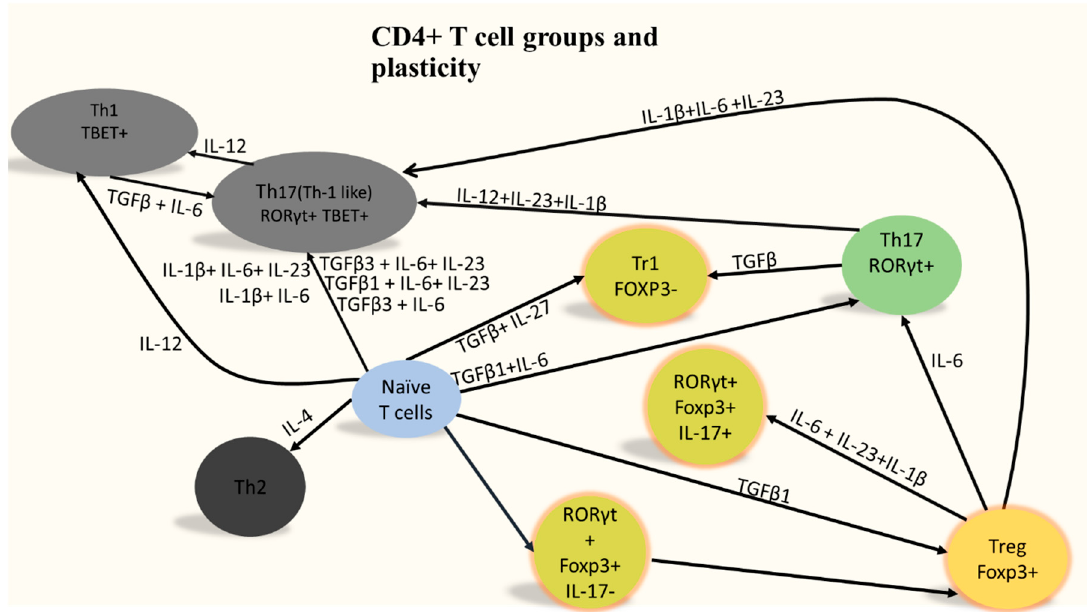
Figure 1. Naïve CD4+ T cells differentiation. After migrating from the thymus to the periphery, CD4+ T cells differentiate in the periphery into Th1, Th2, Th17, and Treg. CD4+ T cells are highly plastic with possibility of changing the fate of the cell based on its cytokines’ microenvironment. Tregs known for their ability to suppress proinflammatory CD4+ T cells can themselves be converted to highly pathogenic population under the action of IL-1, IL-6, and IL-23. Adapted from [4], copyright Bhaumik and Basu, 2017.